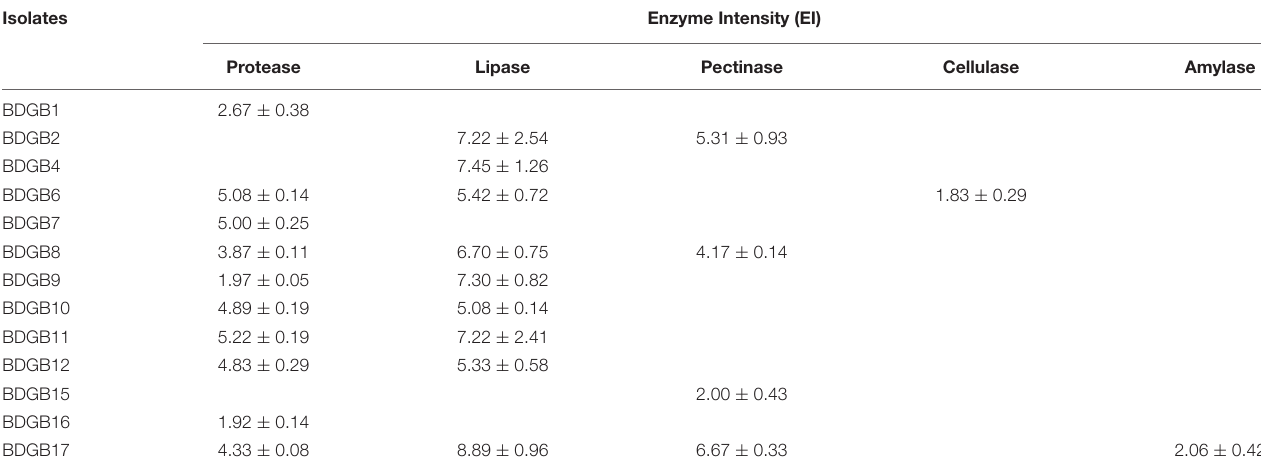
TABLE 3 | Amount of extracellular hydrolytic enzymes produced by the bacterial isolates expressed as enzyme intensity (EI).